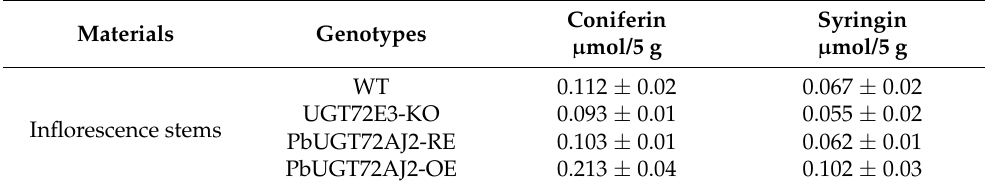
Table 2. HPLC Analysis of soluble monolignol glucosides metabolites in Arabidopsis .